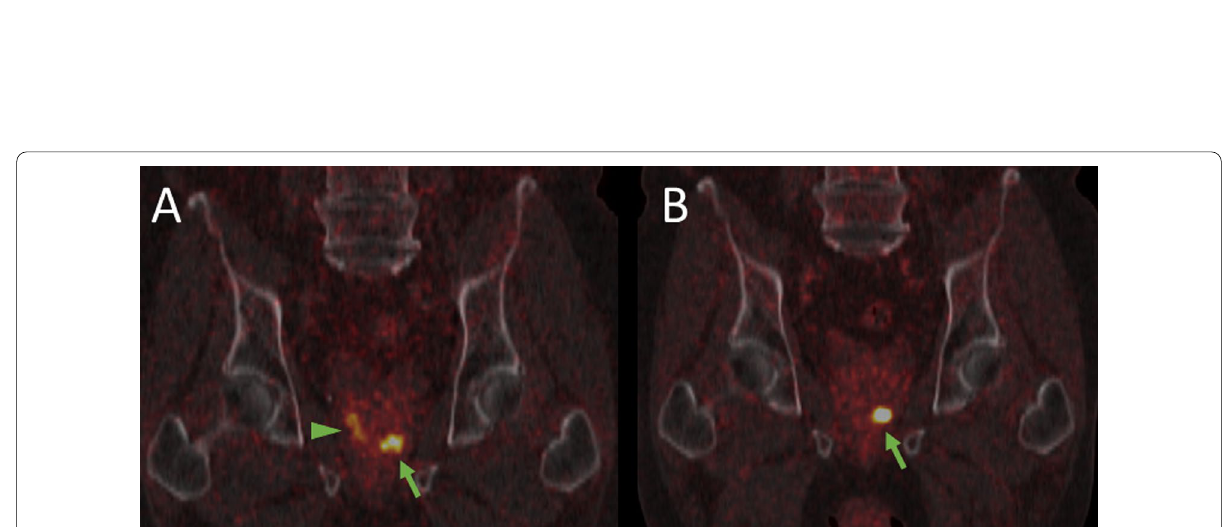
Fig. 3 Coronal fused [ 68 Ga]-Ga-PSMA-11 ( A ) and [ 18 F]-F-PSMA-1007 PET/CT ( B ). Concordant focal uptake in the primary tumor in the left apical lobe (green arrow). The longitudinal uptake in the peripheral lobe in the [ 68 Ga]-Ga-PSMA-11 PET/CT (arrowhead) finds no counterpart in [ 18 F]-F-PSMA-1007